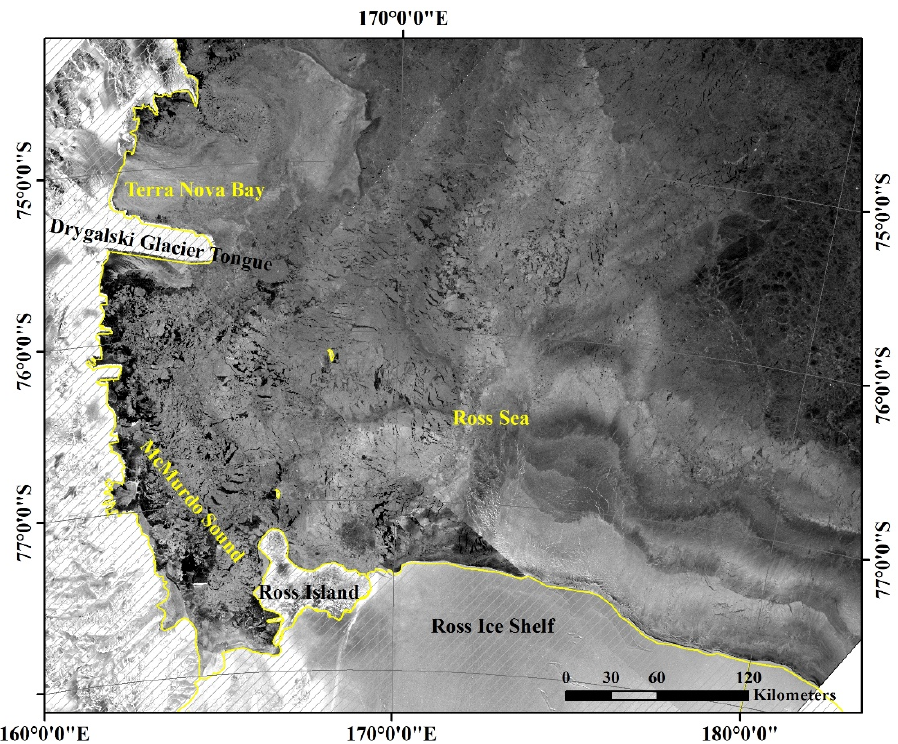
Figure 1. Sentinel-1 SAR image of the Ross Sea with the coastal boundary and named locations of the Ross Ice Shelf, Ross Island, Drygalski Glacier Tongue, McMurdo Sound, Terra Nova Bay, and the Ross Sea.